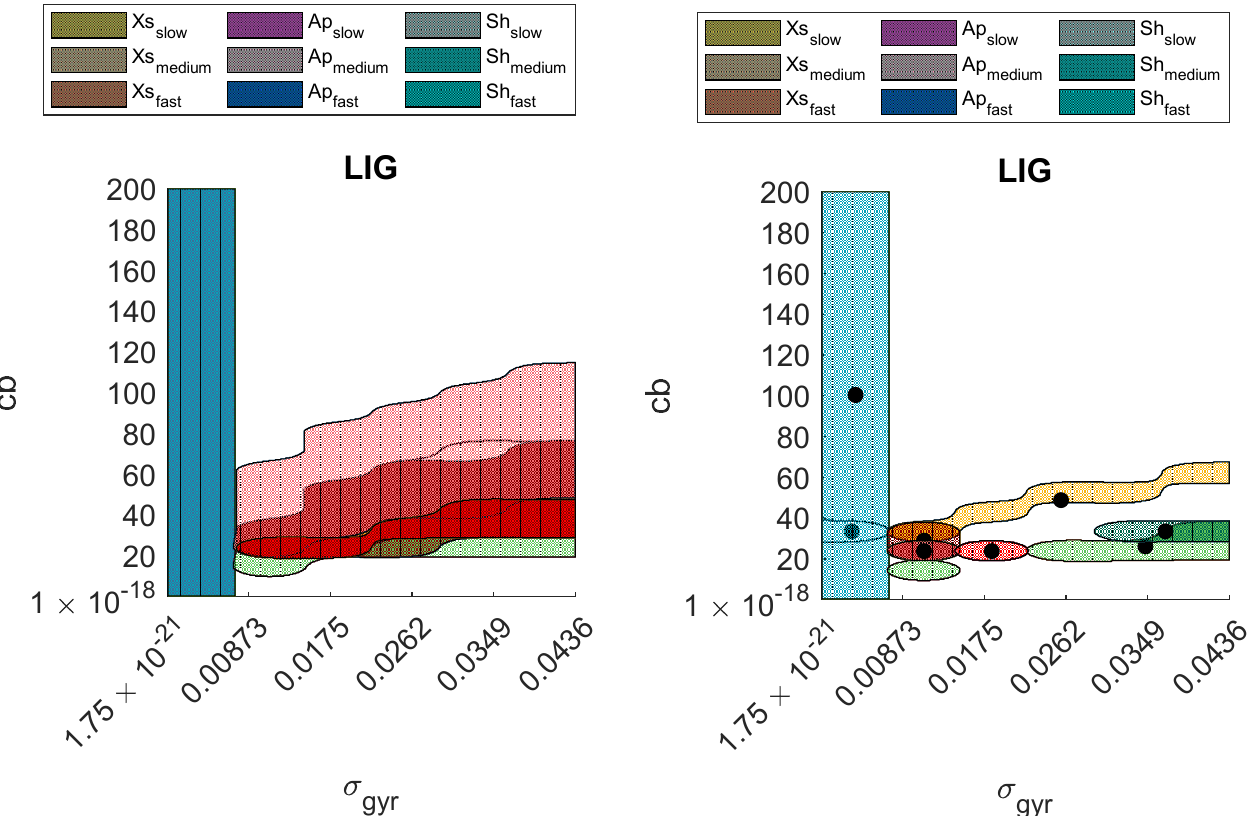
Figure 5. On the left: the optimal regions (one for each experimental scenario) obtained for LIG. On the right: the suboptimal regions (one for each experimental scenario) and their centroids obtained for LIG.